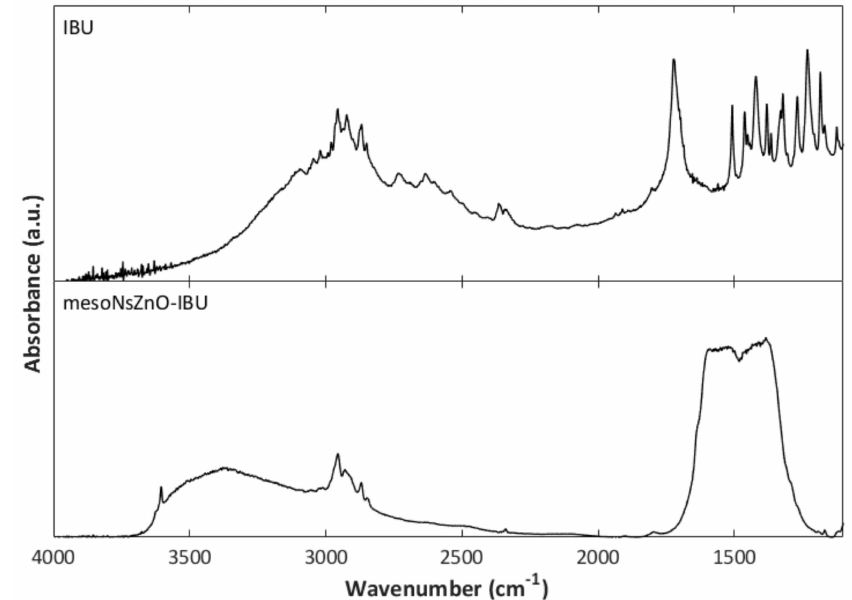
Figure 8. FTIR spectra of IBU and mesoNsZnO-IBU system obtained after a contact time of 24